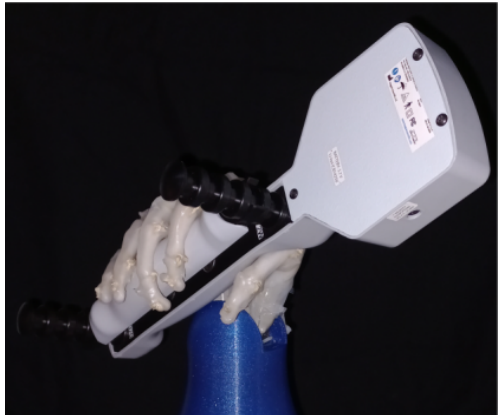
Figure 13. Experimental set up for force